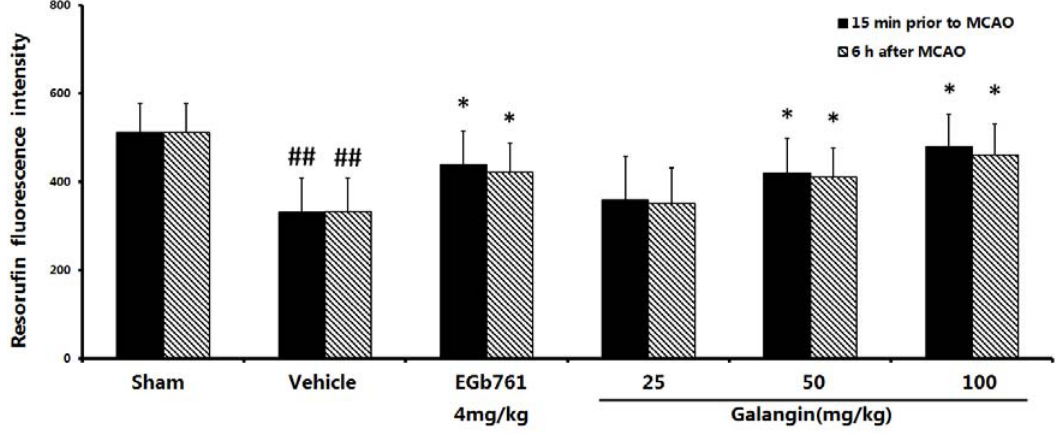
Figure 4. Effects of galangin on mitochondrial function caused by MCAO. EGb761 and galangin were both administered by i.g. 15 min prior to MCAO and 6 h after MCAO. The values were expressed as the mean ± SD (n = 10), and the data were analyzed by one-way ANOVA. ## p < 0.01, # p < 0.05 versus the sham group; ** p < 0.01, * p < 0.05 versus the vehicle control.